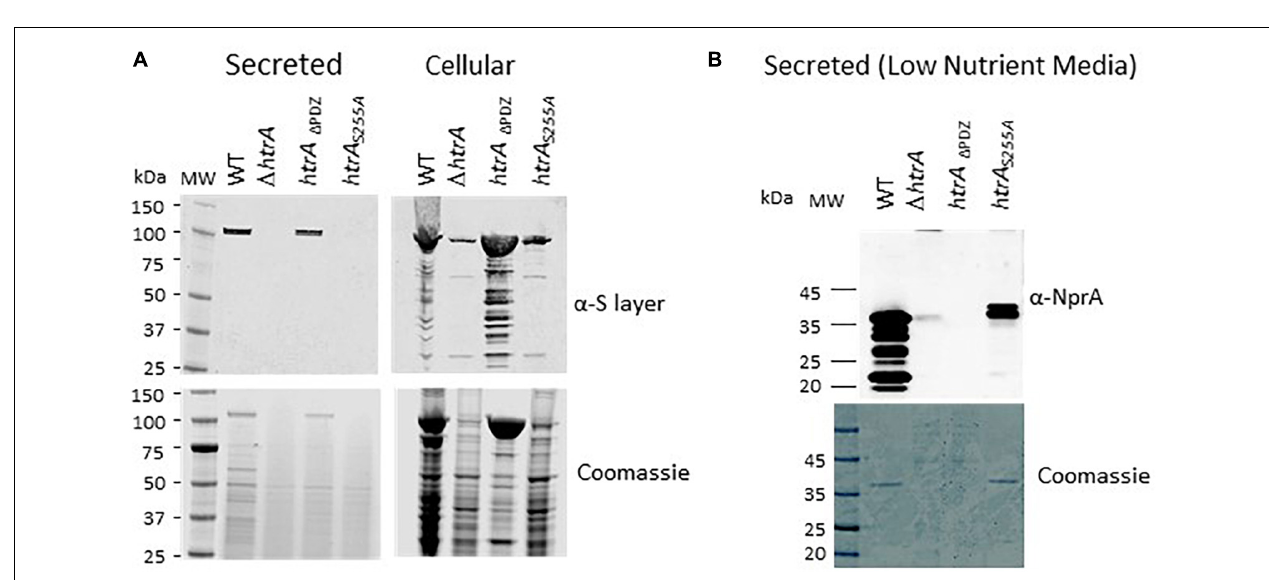
FIGURE 5 | Expression of S-layer proteins and of the NprA secreted protease by the B. anthracis parental WT (cid:49) V, the (cid:49) V (cid:49) htrA and the (cid:49) V strains exhibiting modified htrA alleles (cid:49) V htrA DPDZ and (cid:49) V htrA S255A . (A) Western blot analysis of the secreted and cell associated protein fractions collected from BHI cultures of the strains using anti-S layer antibodies. (B) Western-blot analysis of the secreted protein fraction collected from low-nutrient NBY cultures of the strains using anti-NprA antibodies.